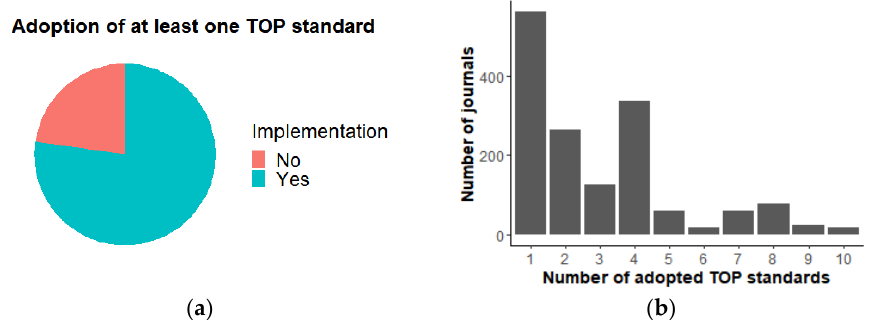
Figure 2. Overview of the adoption of TOP standards across 2000 journal policies from the TOP Factor metric. ( a ) Pie chart that shows the number of journals that implement at least one TOP standard: No-indicates journals that do not implement TOP standards (N = 455, TOP Factor = 0), Yes-indicates a number of journals that implement at least one TOP standard (N = 1545, TOP Factor > 0). ( b ) Histogram of the number of journals that adopt one or more TOP standards. An individual journal can adopt up to eight TOP standards, however, two additional interventions-“Open Science badges” and “Registered Reports”-were added to the standards for this plot. Thus, category 10 corresponds to journals that adopt all 8 standards and 2 interventions.